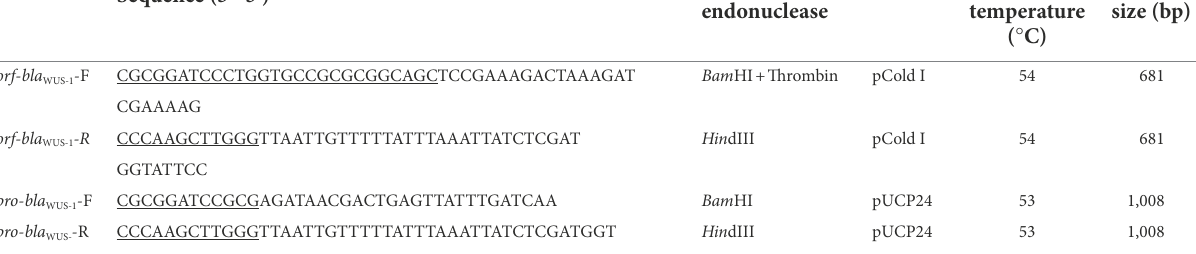
TABLE 2 Cloning primers for the bla WUS-1